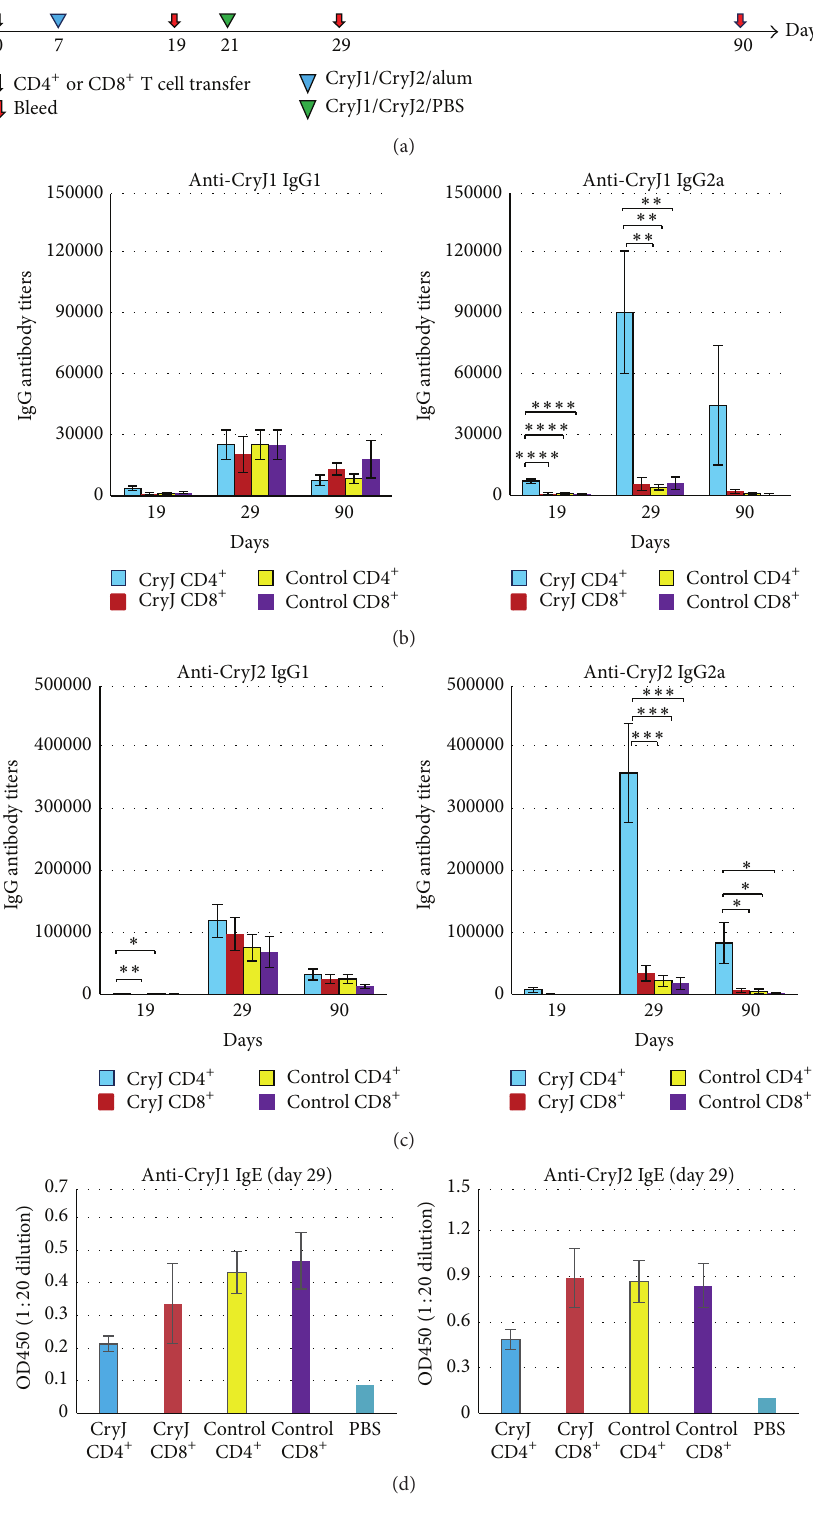
Figure 6: Transfer of CD4 + , but not CD8 + , T cells primes a Th1 antibody response in recipients. (a) Schematic view of vaccination protocol. Two groups of mice were immunized with control vector or mixed 50 𝜇 g CryJ1-LAMP and 50 𝜇 g CryJ2-LAMP three times (weekly). Two weeks after the last injection, mice were sacrificed and spleens were removed. CD4 + or CD8 + T cells were isolated and 1 × 10 7 CD4 + or 7×10 6 CD8 + T cells per mouse were transferred into na¨ıve mice accordingly ( 𝑛 = 5 ) on day 0 through tail vein. Recipients were subsequently boosted with 5 𝜇 g CryJ1 and 5 𝜇 g CryJ2 and bled as indicated. Anti-CryJ1 (b) and anti-CryJ2 (c) IgG1 and IgG2a antibodies were analyzed by ELISA. (d) IgE antibodies were determined by ELISA and depicted are results of OD 450 values at a serum dilution of 1 :20. All data are shown as mean ± SEM. ∗ 𝑝 < 0.05 , ∗∗ 𝑝 < 0.01 , ∗∗∗ 𝑝 < 0.001 , and ∗∗∗∗ 𝑝 < 0.0001